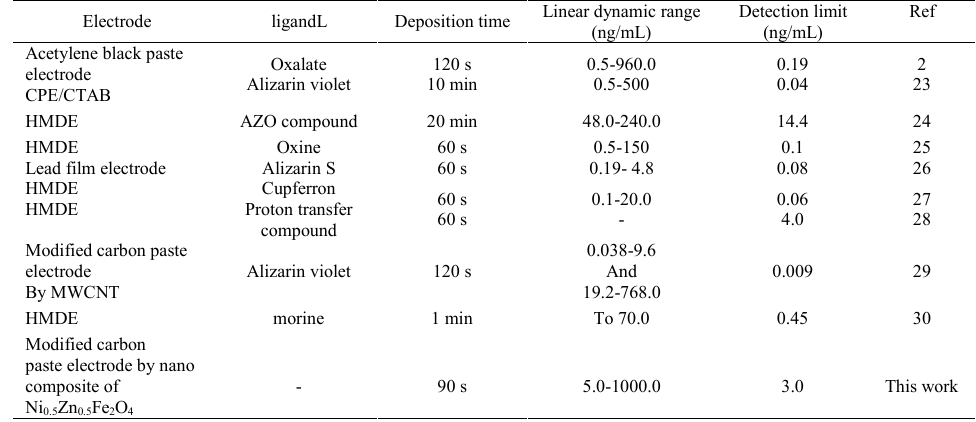
Table 2b. Comparison of Some critical points in the present work compared with some previous works for determination of Mo (VI)